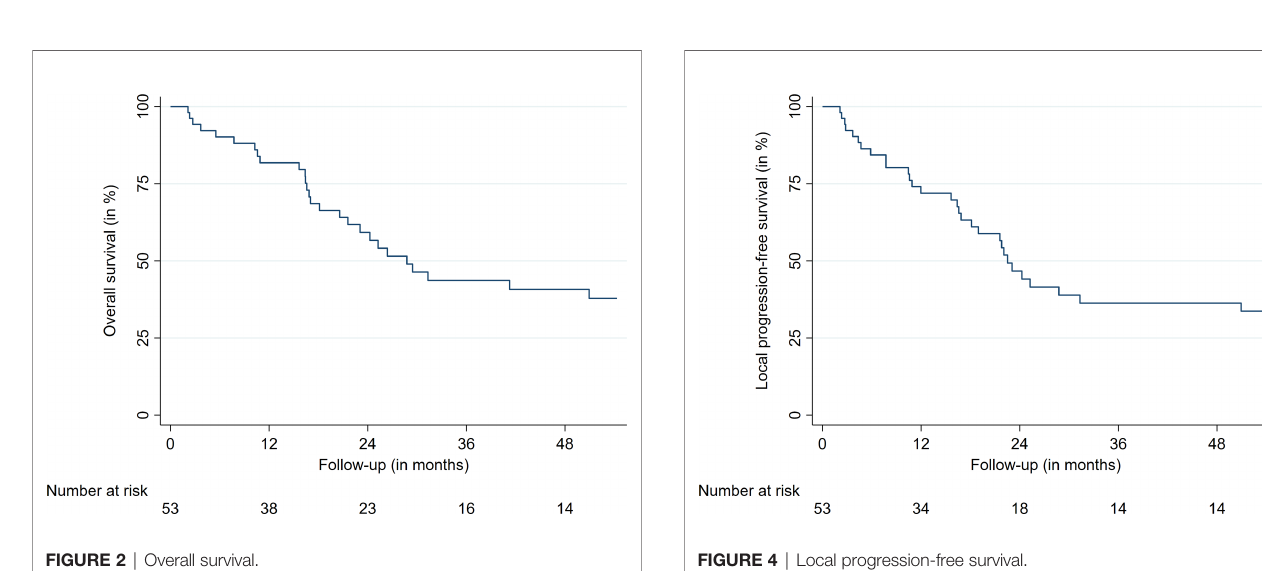
FIGURE 2 | Overall survival.